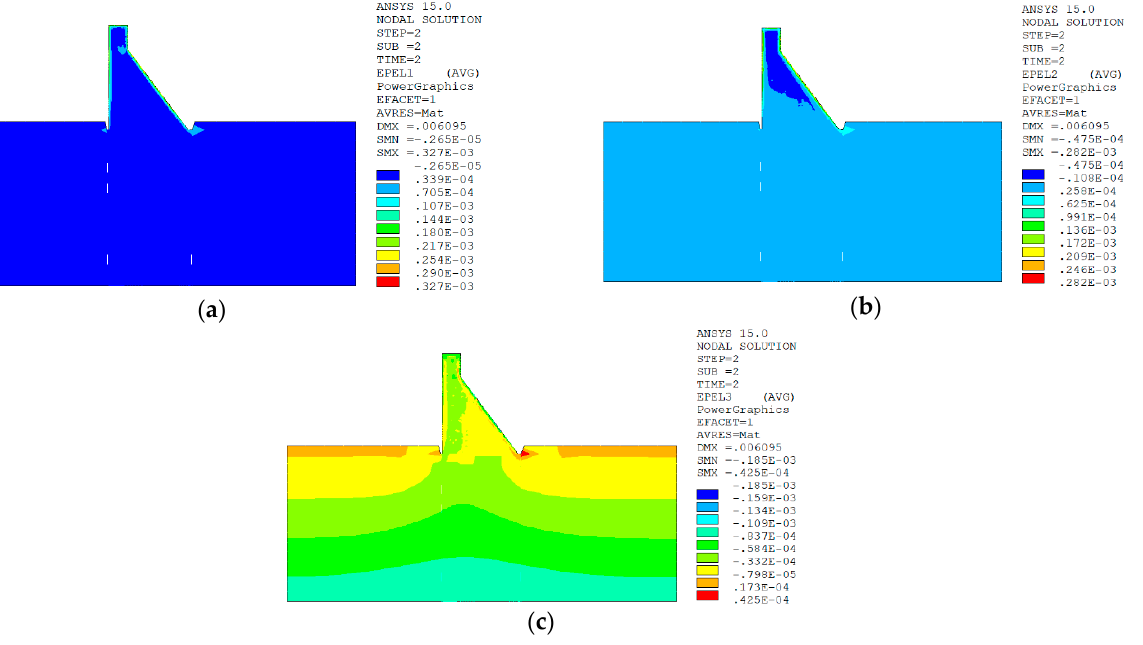
Figure 17. The cloud charts of the three principal strains on the section z = 21 m are calculated by the macro-meso model under the temperature drop condition, ( a ) The cloud chart of the first prin- cipal strain, ( b ) The cloud chart of the second principal strain, ( c ) The cloud chart of the third prin- cipal strain.